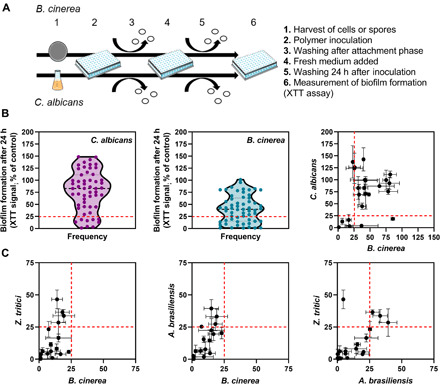
Biofilm formation on potential anti-attachment materials.Eighty polymers showing the lowest fungal attachment (from the preceding microarray-spot screen) were selected for further study. These materials were scaled up to coat the 6.4-mm-diameter wells of 96-well plates. Polymers showing surface cracking were excluded from the analysis. (A) Procedure for assessment of fungal biofilm formation on coated 96-well plates. (B) Extent of biofilm formation across the different polymers for C. albicans and B. cinerea. Materials of interest were designated as those showing <25% biofilm formation (dashed line), as compared with control microplate wells that were not coated with polymer. The full data together with names and structures of the polymers of interest are listed in tables S2 and S3. (C) Polymers of interest for B. cinerea were also tested for biofilm formation by the filamentous fungi Z. tritici and A. brasiliensis. Biofilm was again assessed after 24 hours with XTT. The R2 and P values for the Pearson correlations were 0.307 and 0.014 (Z. tritici and B. cinerea), 0.558 and 0.0002 (A. brasiliensis and B. cinerea), and 0.354 and 0.007 (Z. tritici and A. brasiliensis). The values are means ± SEM from at least three independent experiments.